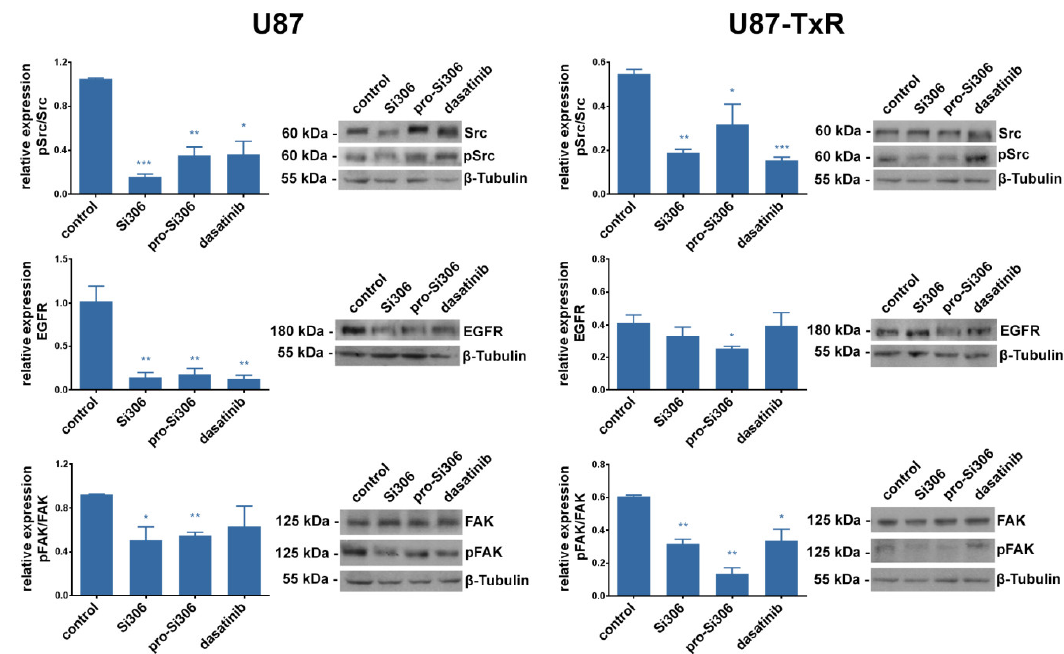
Figure 5. Si306 and pro-Si306 inhibit the activity of Src and its upstream signaling pathway components in GBM cell lines. Representative Western blot images of pSrc, Src, epidermal growth factor receptor (EGFR), pFAK, and focal adhesion kinase (FAK) protein expression in U87 and U87-TxR cells after 24 h treatment with 5 µ M Si306 and pro-Si306 are shown. Histograms represent Western blot data expressed as phosphoprotein level relative to total protein level (Src and FAK) or total protein expression (EGFR), all normalized to β -tubulin. Values are expressed as mean ± SEM ( n = 3). Statistical significance between treated and control group is shown as * ( p < 0.05), ** ( p < 0.01), and *** ( p < 0.001), uncropped western blot in Figure S8.